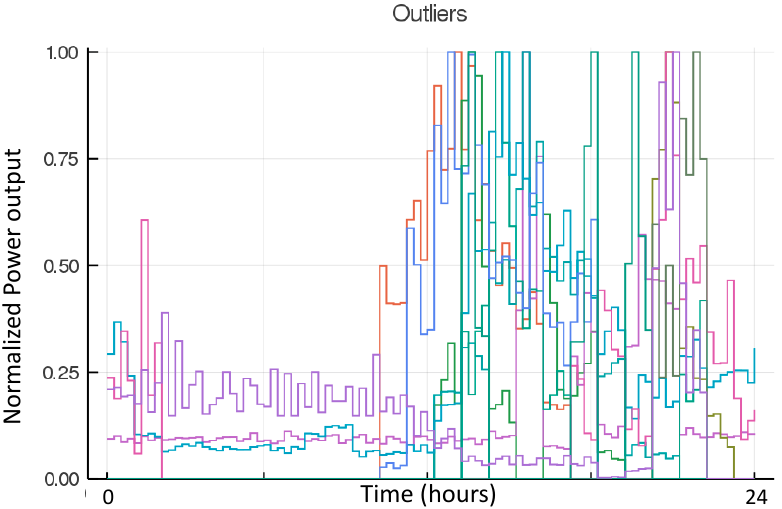
Figure 12. Data of 362 actual distribution customers from Santiago, Chile.